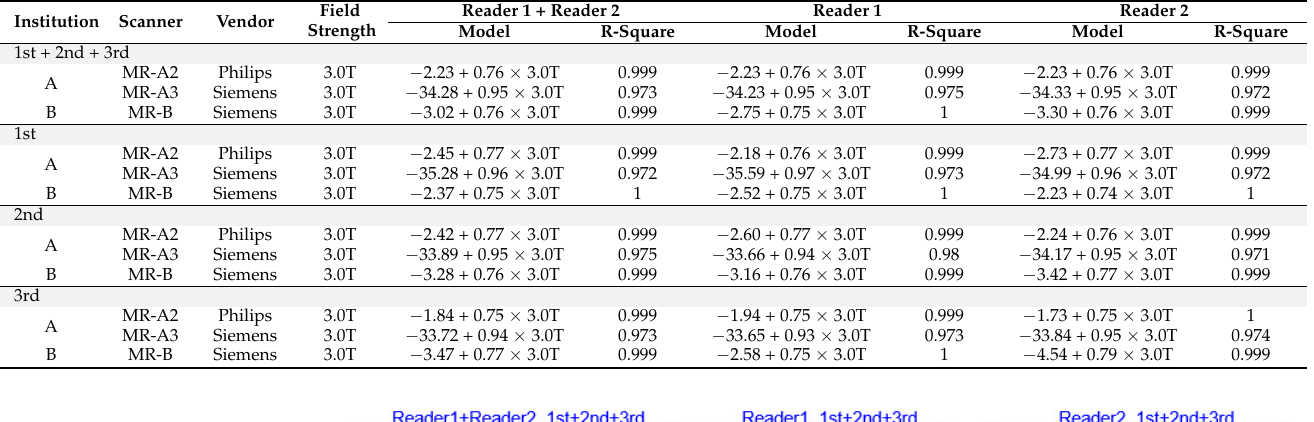
Table 2. Linear regression model of 1.5T on 3.0T.